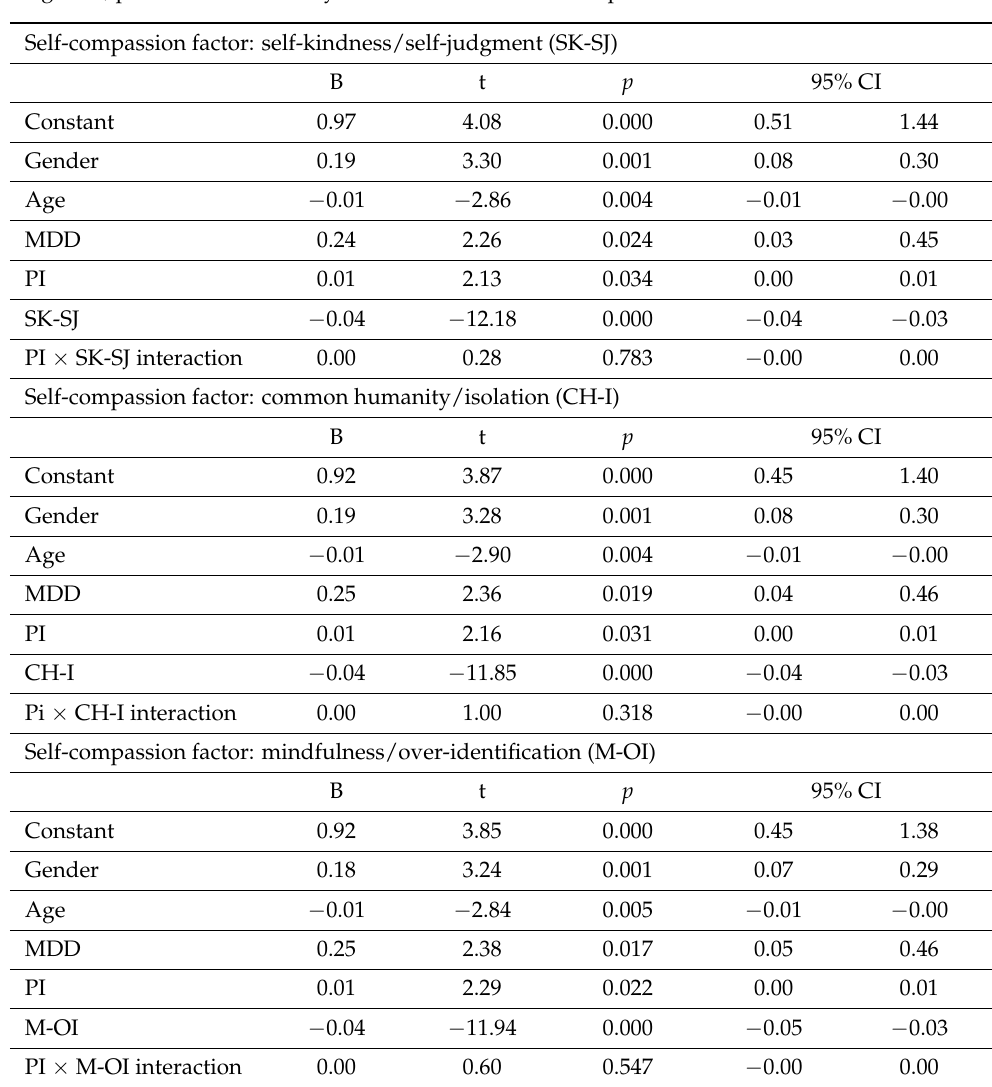
Table 3. Regression analysis on the prediction of DASS-21 scores by gender, age, mental disorder diagnosis, perceived infectability and each factor of